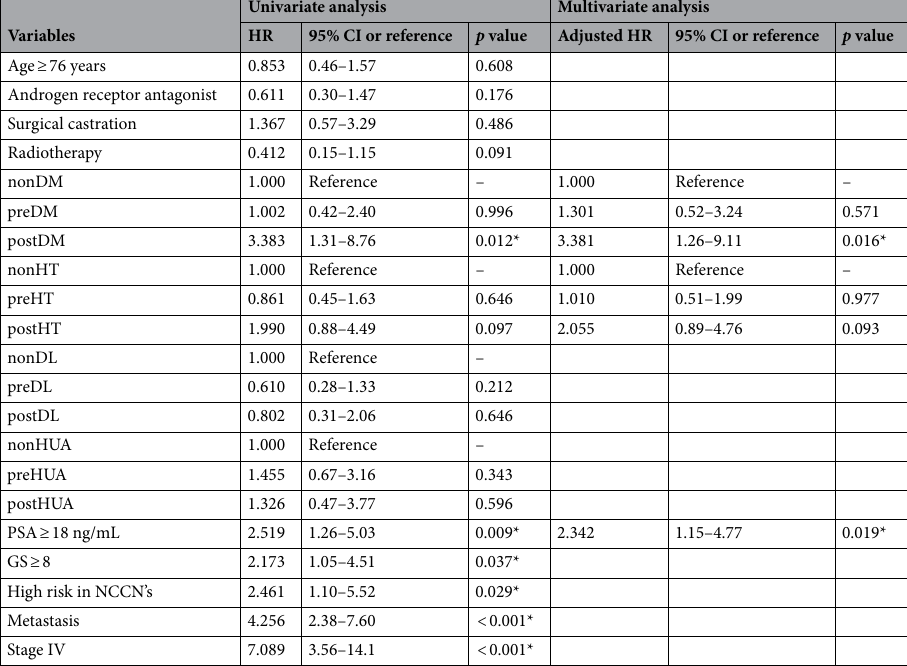
Table 2. Cox proportional univariate and multivariate analysis of the association between variables and CRPC progression. PSA prostate-specific antigen, GS Gleason score, NCCN’s The National Comprehensive Cancer Network’s classification, HR hazard ratio, CI confidence interval. *Statistically significant ( p < 0.05).